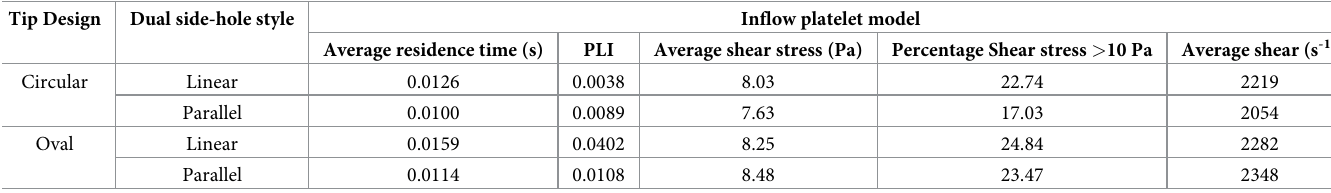
Table 5. Platelet parameters for the dual side-hole